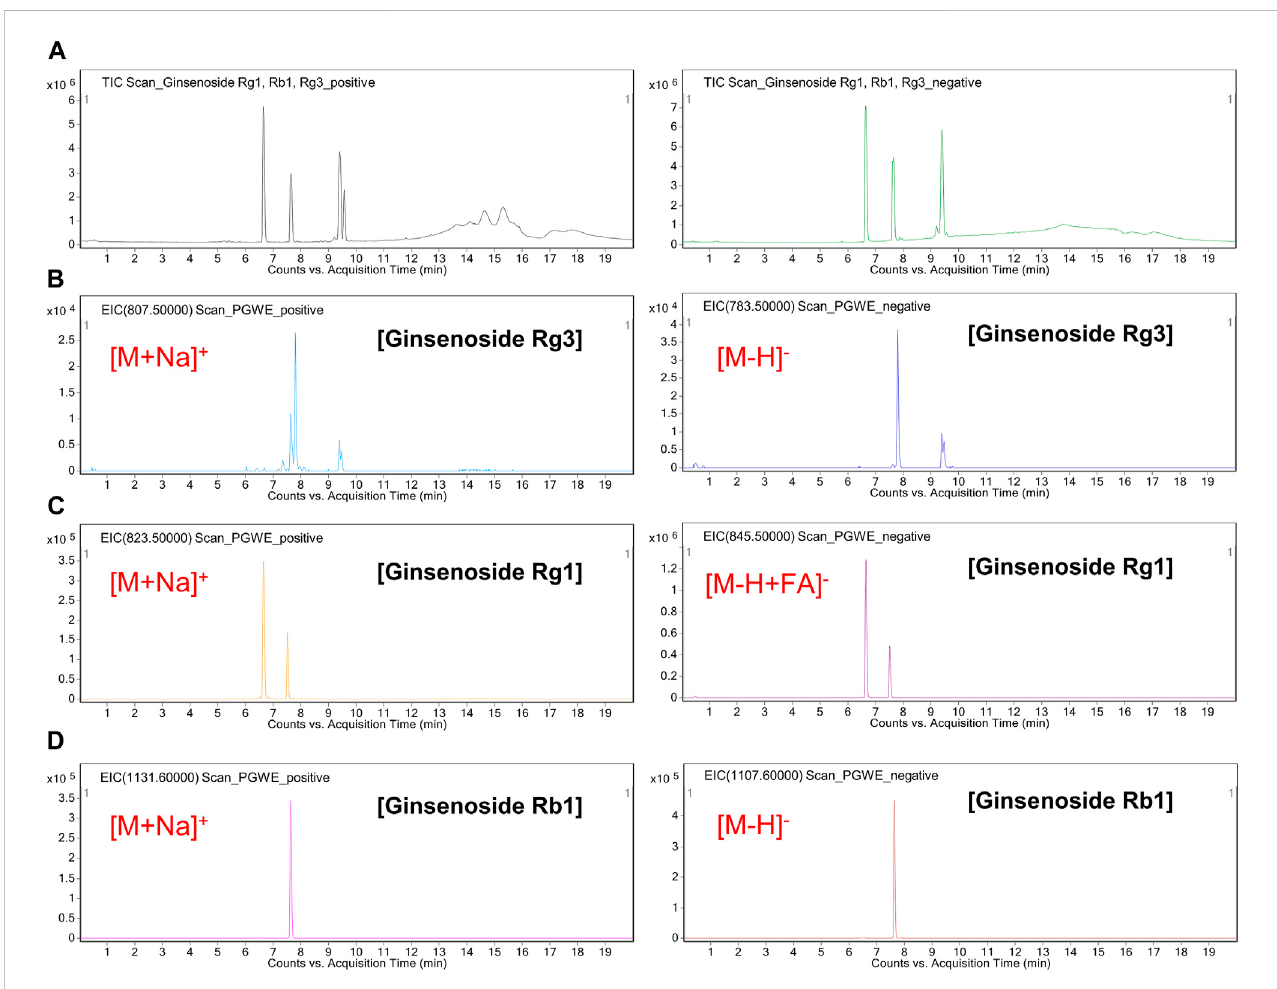
FIGURE 1 LC/MS analysis of PGWE (A) Positive or negative TIC of a cocktail of ginsenoside (Rg1, Rb1, Rg3) was analyzed using the ESI method (B – D) Positive or negative EIC of the PGWE was obtained at m/z 783.5 or at m/z 807.5, m/z 845.5 or m/z 823.5, m/z 1107.6 or m/z 1131.6, respectively. PGWE, Panax ginseng C. A. Meyer water extract; TIC, total ion chromatogram; ESI, electrospray ionization; EIC, extracted ion